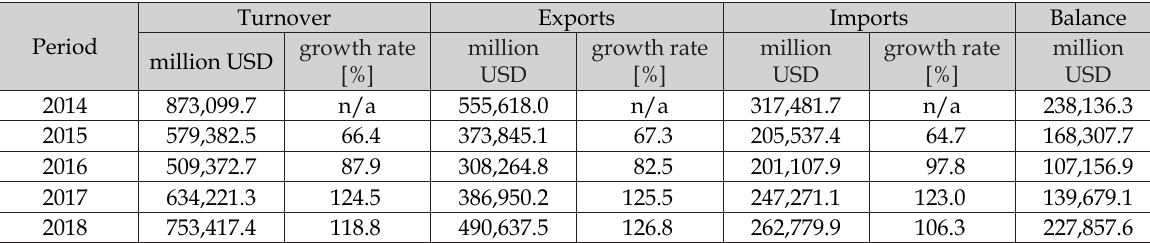
Table 2. Dynamics of foreign merchandise trade of the EAEU with third countries.